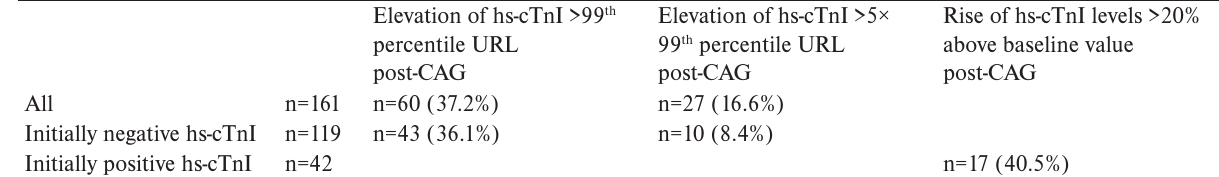
Table 3. Elevation of hs-cTnI in the CAG-only subgroup.